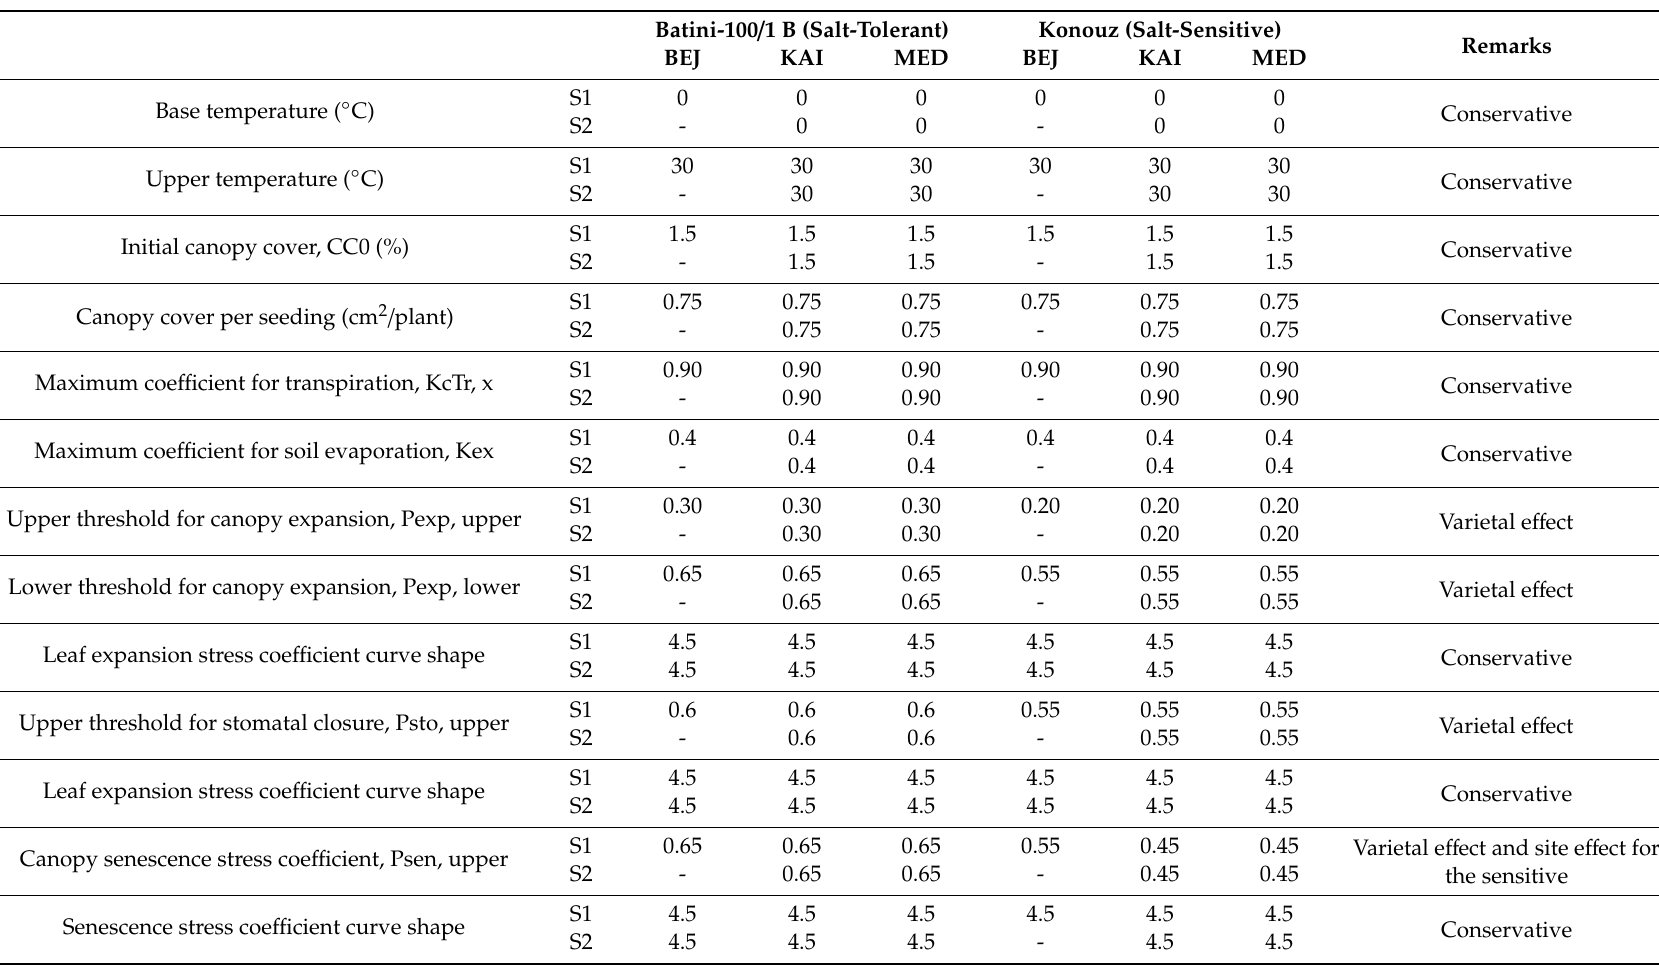
Table 4. Final values of di ff erent model input parameters obtained after calibration for two genotypes under di ff erent salinity levels (S1 = 2 dS m − 1 ; S2 = 13 dS m − 1 ).